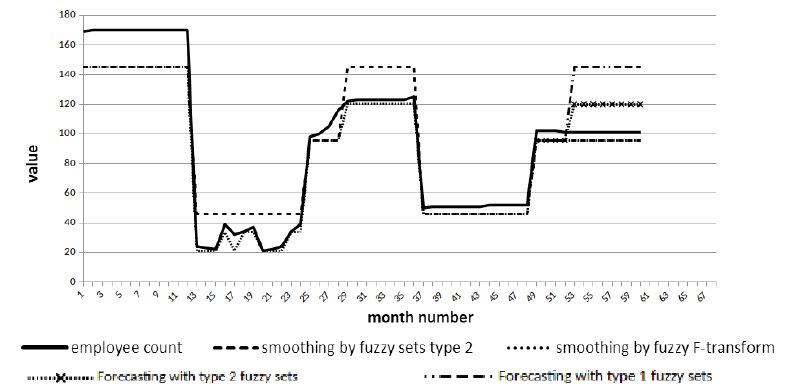
Figure 14. Approximation and forecasting the time series of the number of